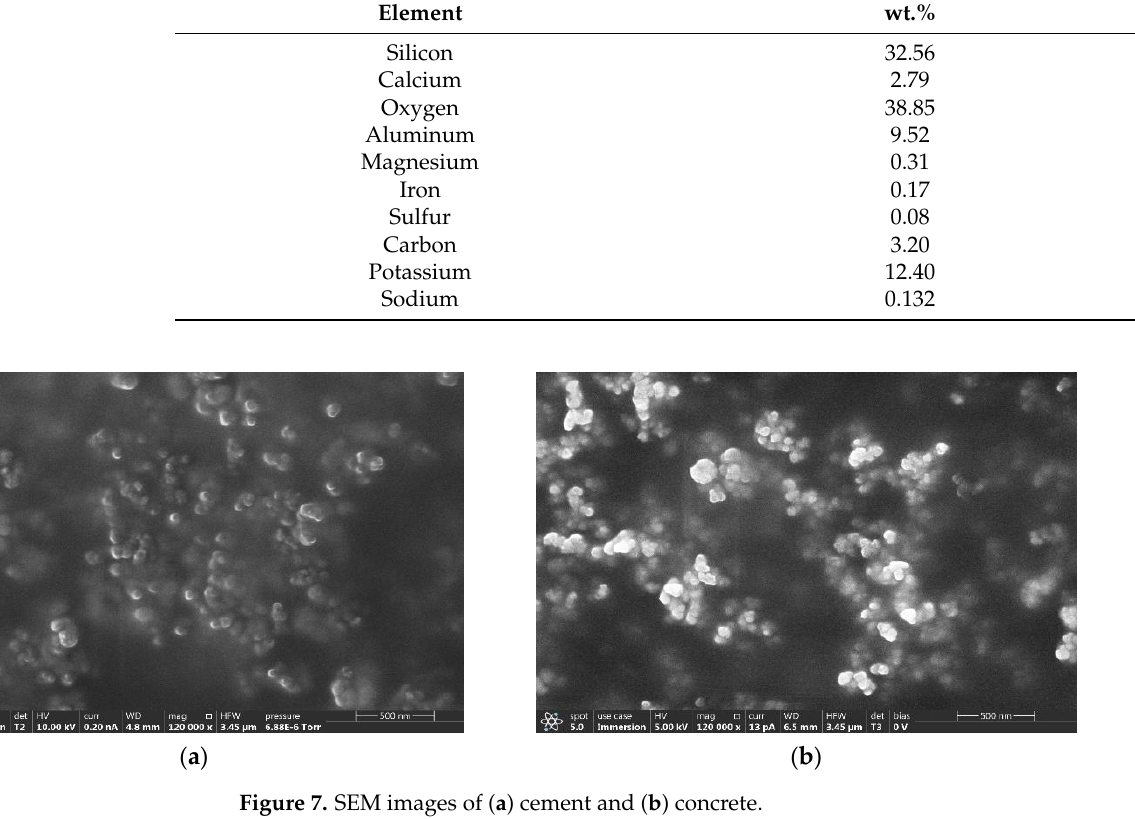
Table 4. Elemental composition of concrete dust from EDS.